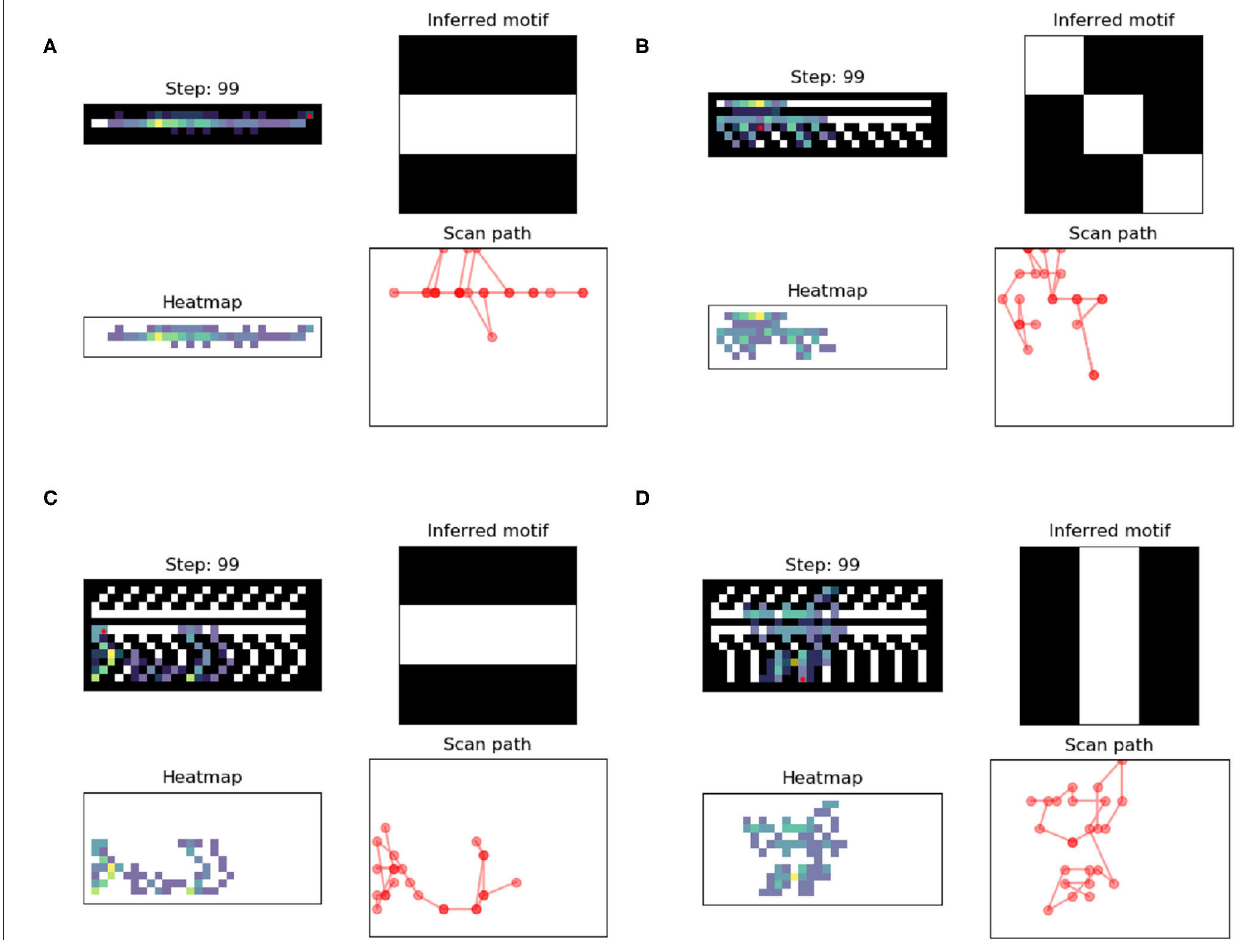
FIGURE 4 | For each panel [ (A–D) , or complexity 0 to 3], the upper left quadrant represents the heatmap and the final location (red dot), with the motifs superimposed at the end of the 99 trials; the lower left quadrant represents the heatmap alone at the end of the 99 trials; and the lower right quadrant represents the scan path over 99 trials; the upper right quadrant represents the final motif perceived. The heatmap represents the paths and the number of times the agent moved over a location. The more often a location was gazed upon, the yellower it became (gradient from blue to yellow). MP4 versions of the experiment can be found at https://github.com/